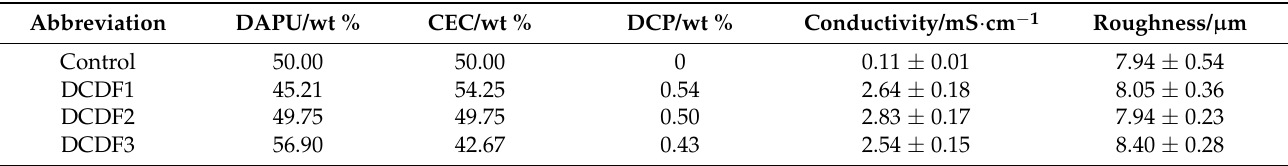
Figure 1. A schematic representation of the preparation process of the DAPU/CEC/DCP (DCD) thin films and their potential as biocompatible conductive polymer coating. DAPU: dialdehyde polyurethane; CEC: N-carboxyethyl chitosan; DCP: double-bonded chitosan modified polypyrrole. Table 1. The basic properties and abbreviated names for the conductive DAPU/CEC/DCP (DCD) thin films (DCDFs) prepared with different formulae. DAPU: dialdehyde polyurethane; CEC: N-carboxyethyl chitosan; DCP: double-bonded chitosan modified polypyrrole.